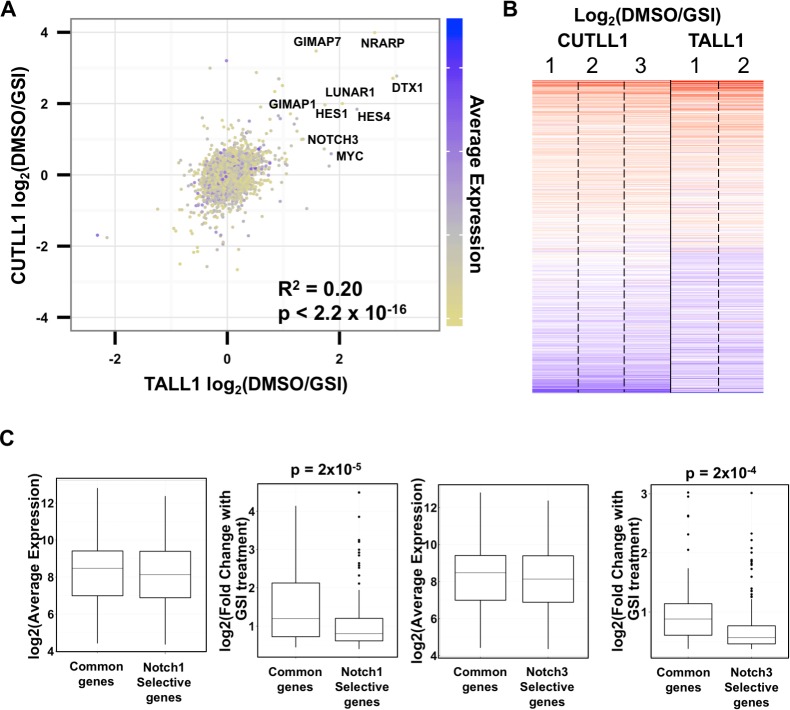
Overlap of NOTCH1- and NOTCH3-regulated genes.(A) Comparison of Notch responsive changes in gene expression between CUTLL1 and TALL1 cell lines. Genes shown are in the top quintile of gene expression, averaged across all samples and represented on a sliding color scale from yellow (low expression) to blue (highest expression). Known NOTCH1 target genes (as indicated) are dynamically regulated in both CUTLL1 and TALL1 cells. (B) Heat map showing genes that exhibit significant changes (p<0.05) in expression between Notch-on and Notch-off states. Genes represented in the heat map are the union of all Notch-dependent genes in both cell lines (n = 1291). The heatmap is ordered vertically by the average fold change in expression across all five rows. (C) Whisker plots comparing average expression and fold-change of genes responding to both NOTCH1 and NOTCH3 (common genes) or selectively to either NOTCH1 or NOTCH3 (selective genes). Though common genes and NOTCH1- and NOTCH3-selective genes have similar overall levels of expression, common genes have a significantly larger fold change in response to GSI treatment. P values were calculated by t-test.